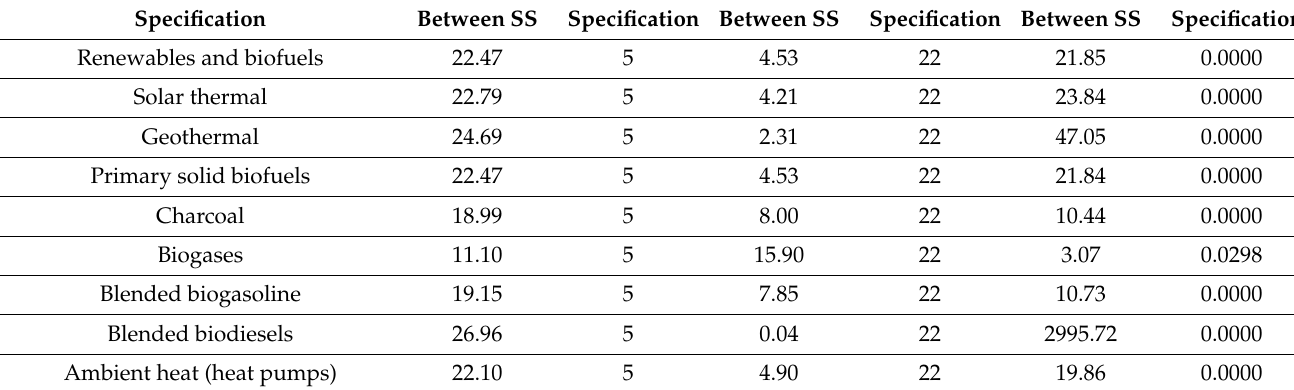
Table 2. Analysis of variance for renewable energy consumption in households’